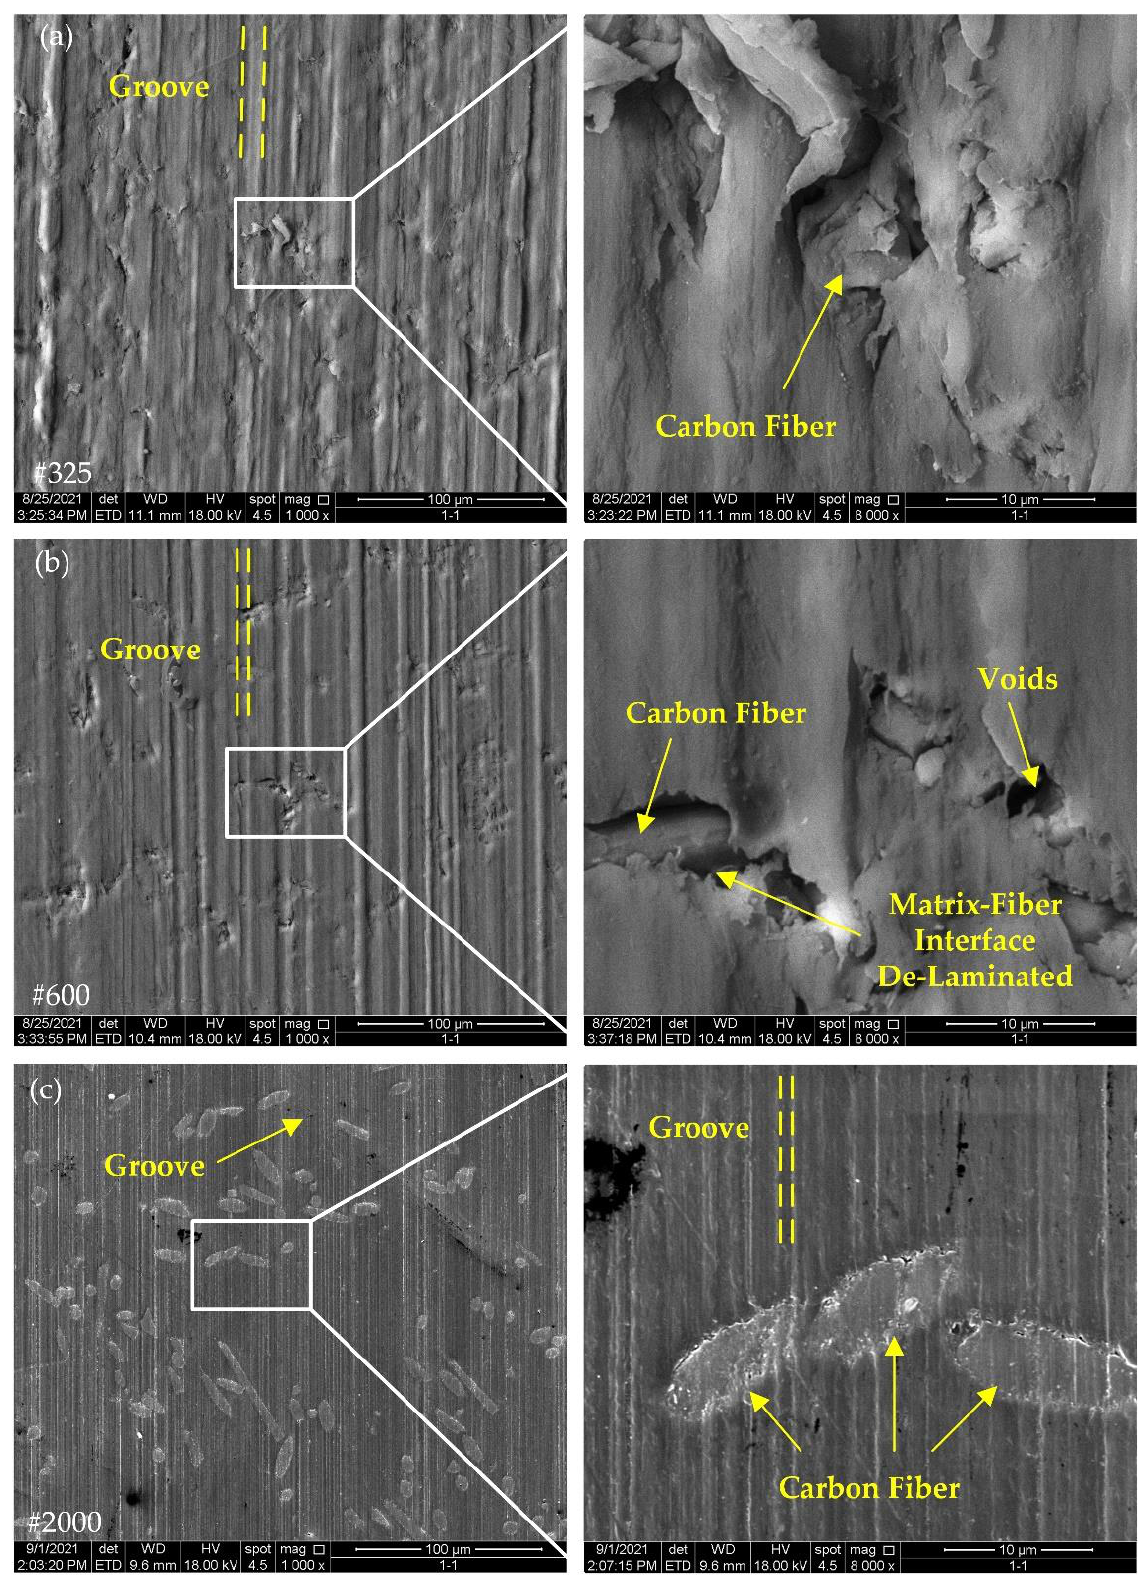
Figure 7. Surface morphology of CF10/PEEK with different grinding wheels: ( a ) grit size #325; ( b ) grit size #600; ( c ) grit size #2000.